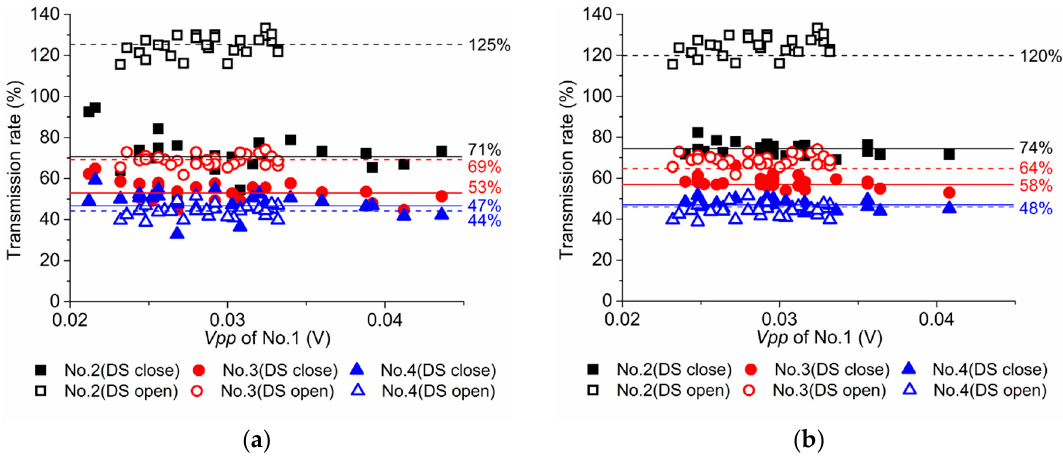
Figure 8. The transmission rates of UHF signals induced by protrusion defect for DS closed and open ( θ = 0°). ( a ) U = 6.5 kV; ( b ) U = 9.6 kV.